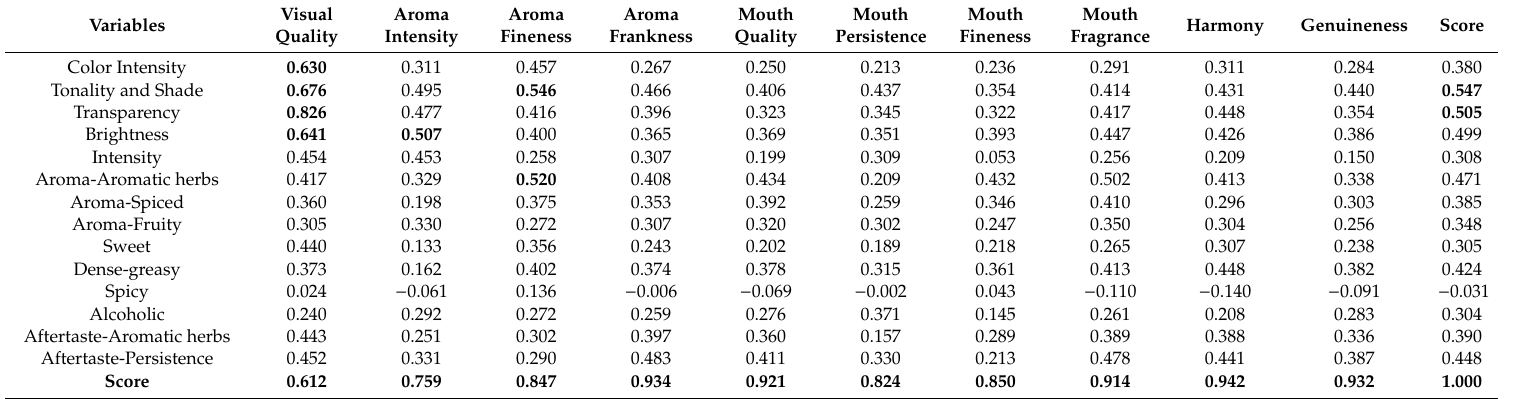
Table 6. Pearson correlation values (R) between descriptive and qualifying parameters in herbal